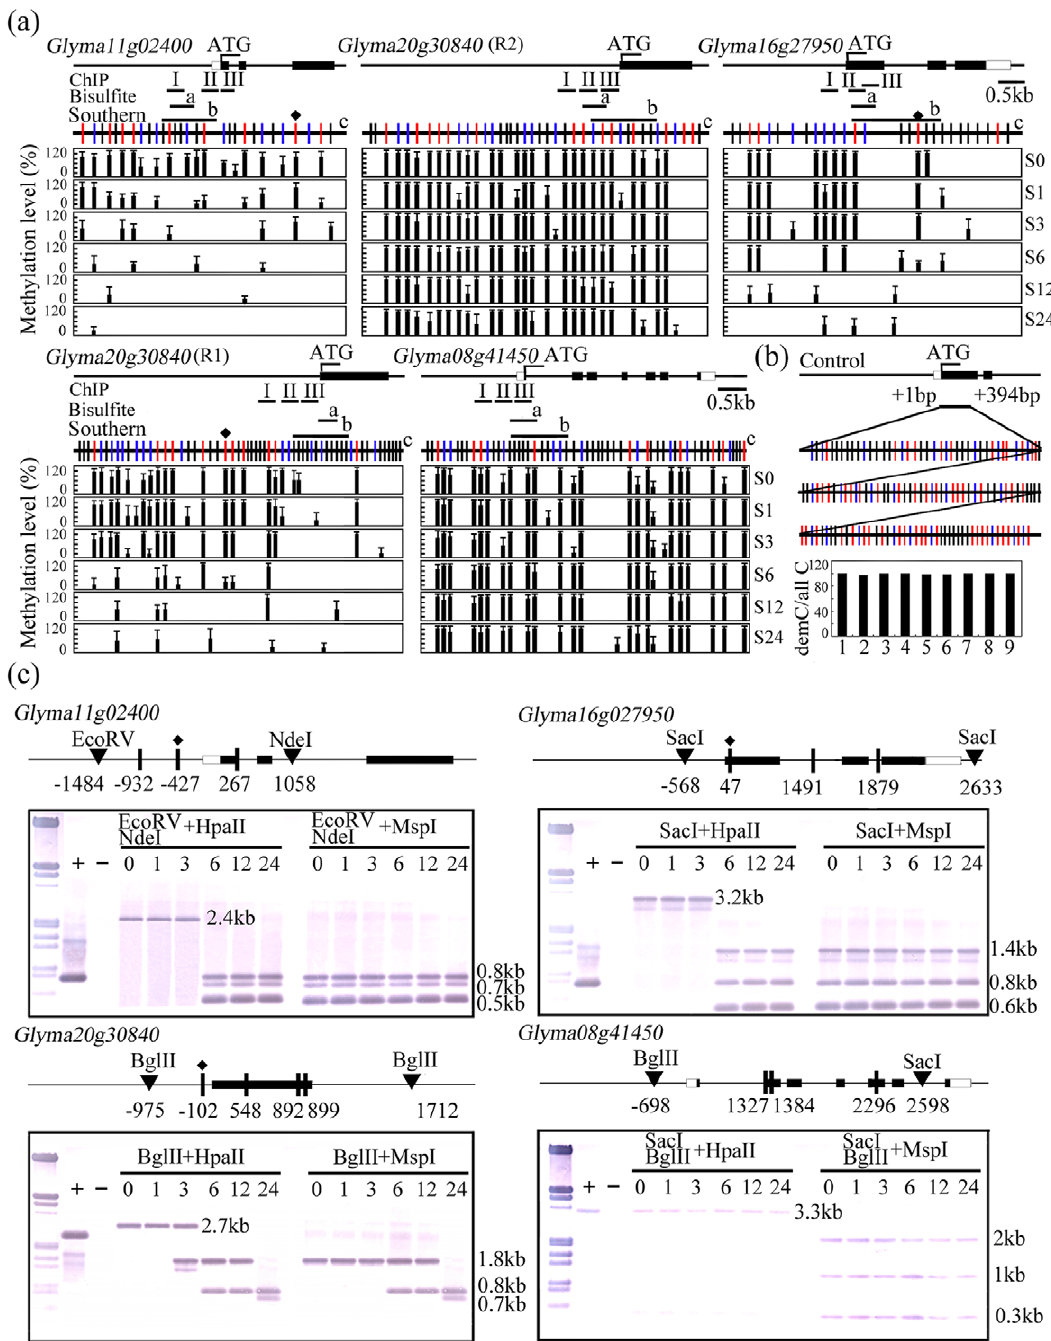
Figure 3. Methylation status of the promoter region of four salinity-responsive TFs in untreated (S0) and salinity-stressed (S1–S24) seedlings (S1: 1h, S3: 3h, S6: 6h, S12: 12h, S24: 24h). (a) The black and white boxes indicate, respectively, exon and untranslated regions. The short bars annotated with ‘‘I, II, III’’, ‘‘a’’ or b’’ indicate, respectively the sequences subjected to ChIP analysis, genomic bisulfite sequencing and those used as probes for Southern blotting. The long vertical bars marked ‘‘c’’ display the distribution of CG dinucleotides (marked with red vertical lines), and CNG (blue vertical lines) and CNN (black vertical lines) trinucleotides. The red vertical lines marked with a rectangular indicate CCGG sites analyzed by Southern blotting. The thick black vertical lines represent the proportion of methylated cytosine. Ten positive clones from each gene’s amplicon were sequenced. The data reflect the outcome of three independent experiments, and error bars represent standard error (SD). (b) The efficiency of the bisulfite treatment to transform unmethylated cytosine to thymine. A fragment of Glyma20g32730 with numerous cytosines was cloned into Dm- E. coli cells and the plasmid was treated with bisulfite in parallel with the soybean genomic DNA. All clones processed showed a transformation rate . 99.7%. (c) Methylation-sensitive DNA gel blot analysis of non-stressed (S0) and salinity-stressed seedlings (S1–S24). Genomic DNA was digested to generate large fragments, then with one or other of the schizomers Hpa II or Msp I. Hybridization probes indicated. A DNA fragment amplified from the probe sequence was used as a positive control ( + ), and ddH 2 O was used as a negative control ( 2 ).